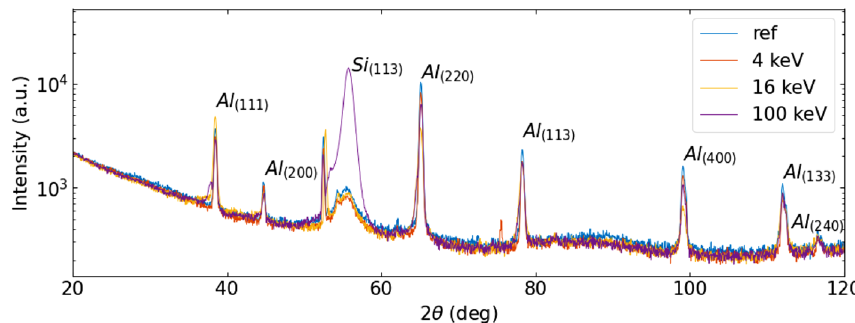
Figure 3. Grazing incidence XRD spectra acquired for the various TiO 2 /Al samples at 1 ◦ in ω .